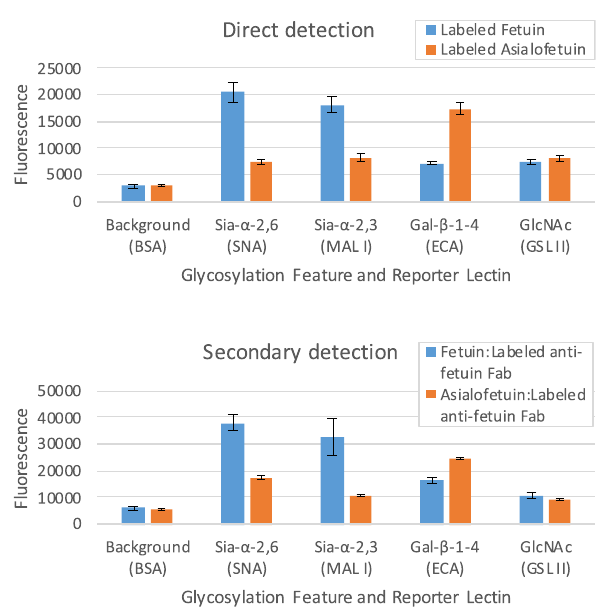
Figure 4. Upper: Multiplexed GlycoSense monitoring of glycofeatures using directly-labeled (SureLight 488) fetuin and asialofetuin. Lower: Indirect detection of glycofeatures employing unlabeled fetuin and asialofetuin, followed by incubation with labeled anti-bovine fetuin Fab fragment. Standard deviations from triplicates are shown as error